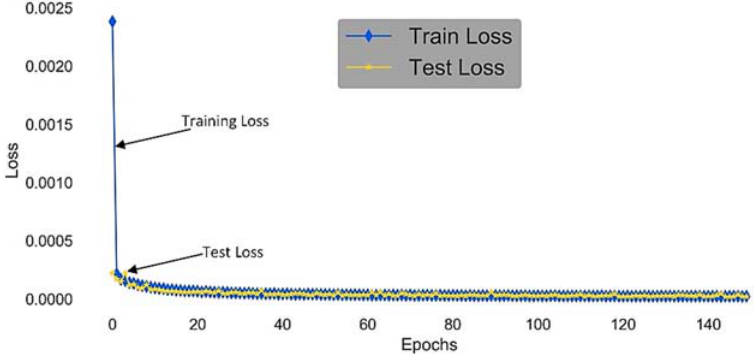
Figure 15 . LSTM learning curve. Figure 15. LSTM learning